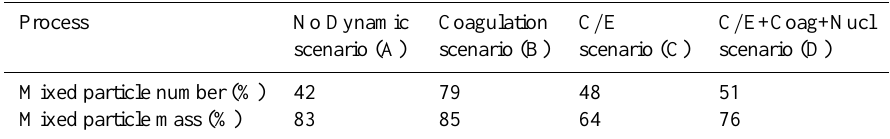
Table 2. Mixing state after 12h